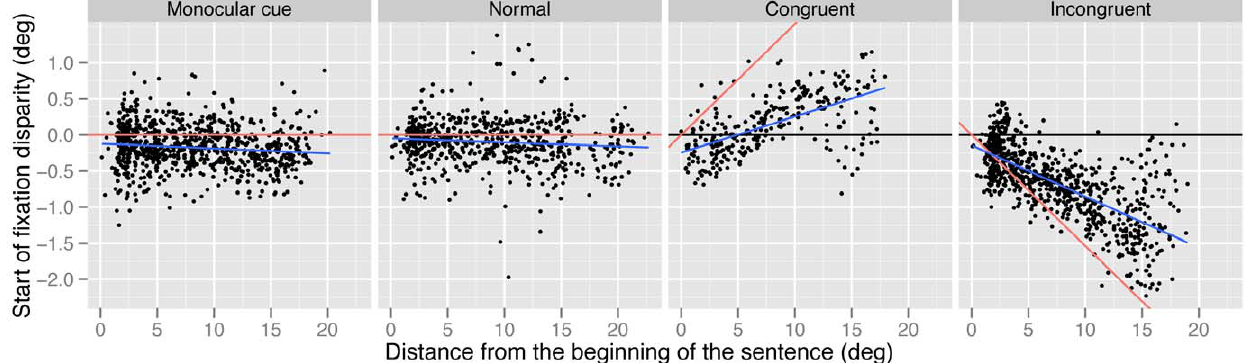
Figure 2. Disparity at the start of fixations, as a function of distance from the beginning of the sentence and experimental condition. Positive values denote crossed fixations (i.e., the eyes are aligned in front of the plane of the screen) and negative values denote uncrossed fixations (i.e., the eyes are aligned behind the plane of the screen). Black lines (set at 0 u ) represent the plane of the display screen; blue lines indicate the effect of distance from the beginning of the sentence on fixation disparity; red lines indicate the disparity that would be produced if subjects were to fuse the sentence as it appeared in virtual depth. doi:10.1371/journal.pone.0035608.g002 PLoS ONE |